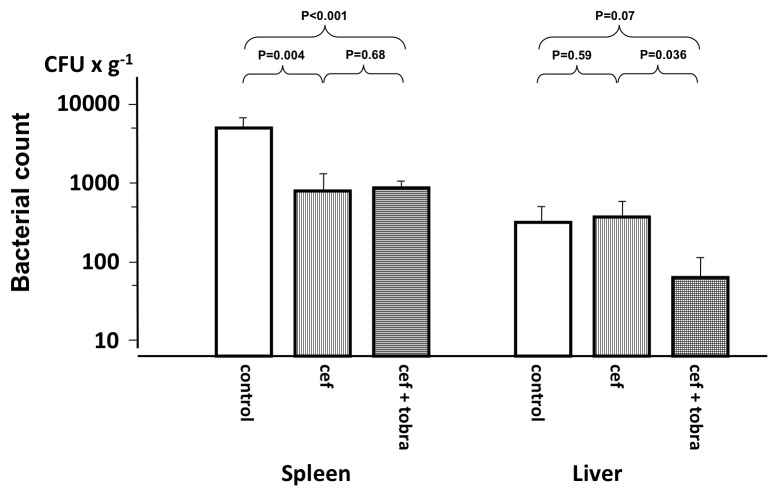
Bacterial count in the spleen and liver at the end of the experiment.Animals treated 4[61] or the combination of cefuroxime and tobramycin (cef+tobra) and control animals. Values are mean±SE (n = 9 in each group).